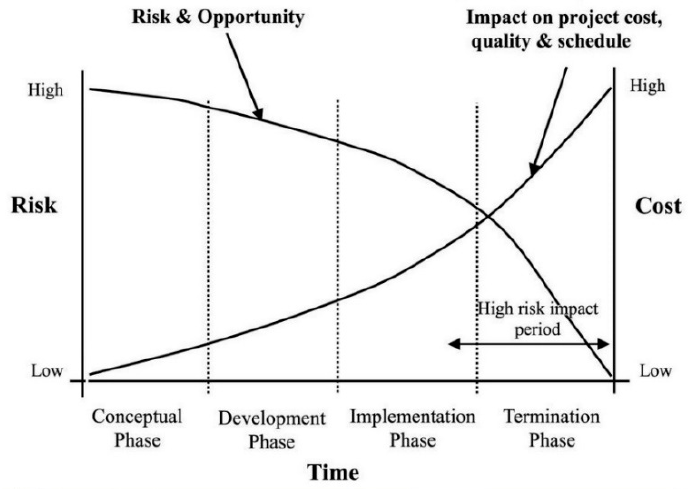
Figure 1. Influence curve (Hlaing et al. 2008).